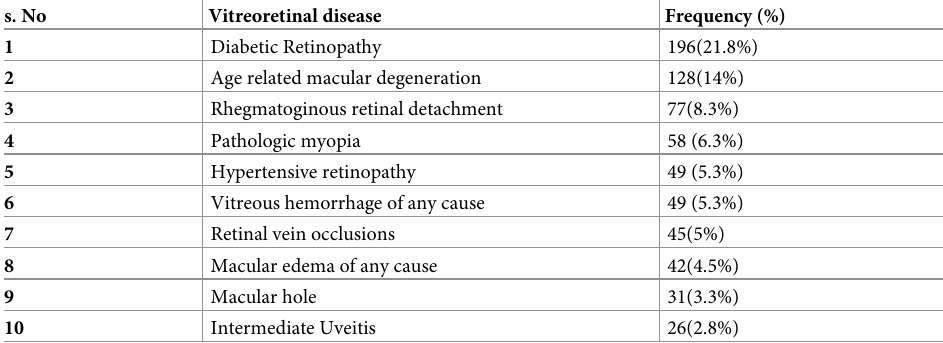
Table 4. The top ten vitreoretinal diseases diagnosed among patients presented to the University of Gondar Ter- tiary eye care and training center, vitreoretina clinic, NW Ethiopia. (n = 918). s.